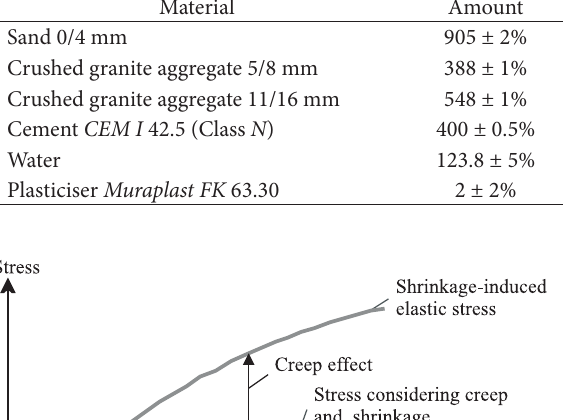
Table 1. Mix proportion of the concrete, kg/m 3 Material